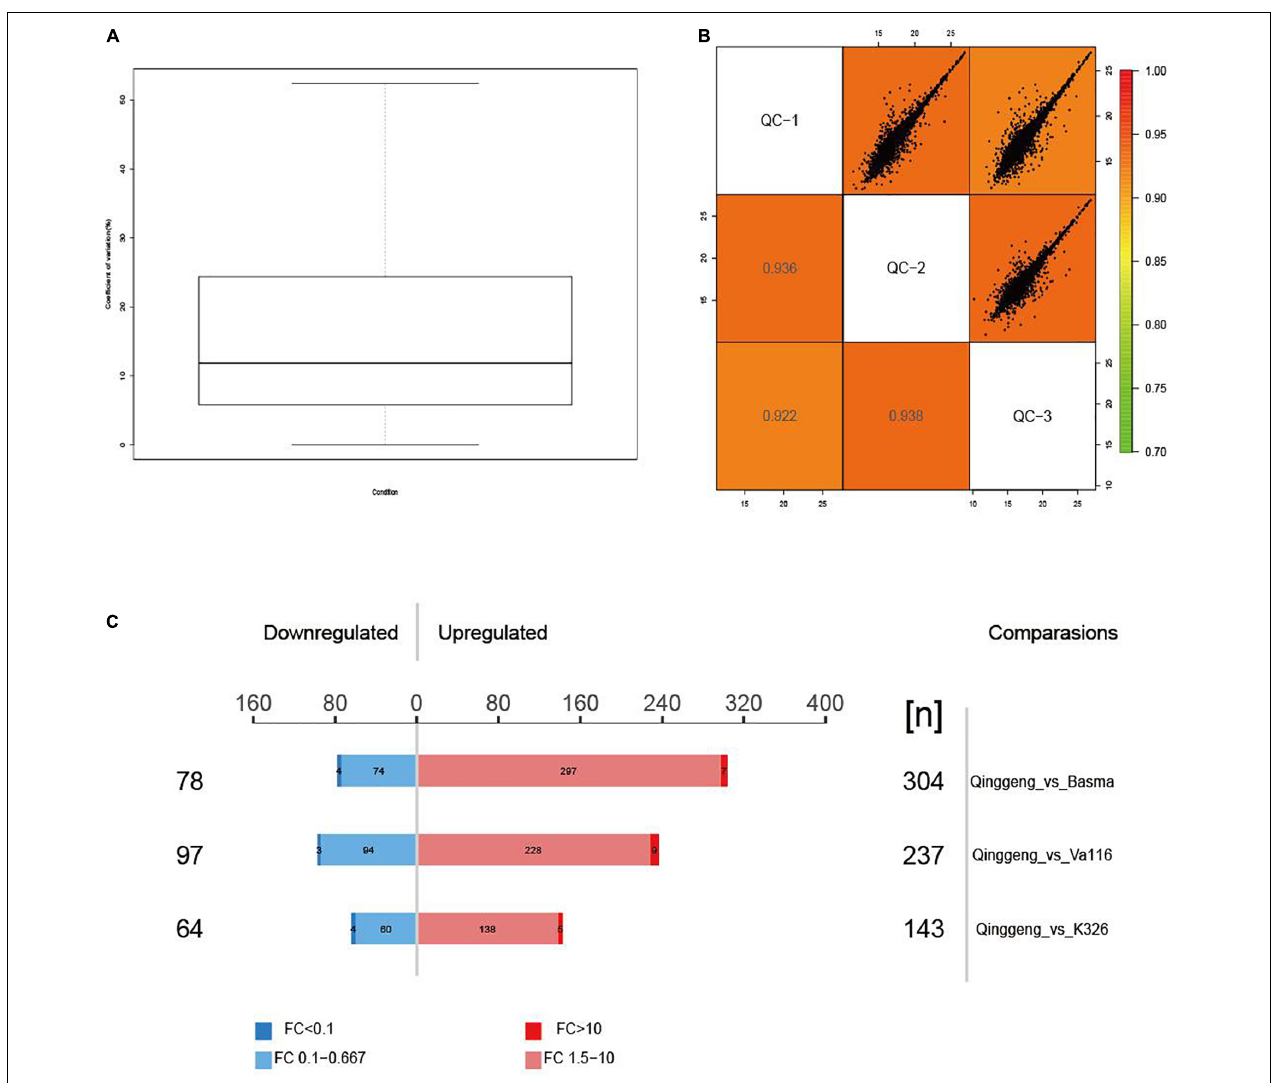
FIGURE 2 | The protein expression abundance test of four tobacco varieties. (A) The distribution of coefficient of variation (CV) of quality control samples. (B) The correlation analysis of quality control samples. (C) Display of differentially expressed proteins in the three comparison